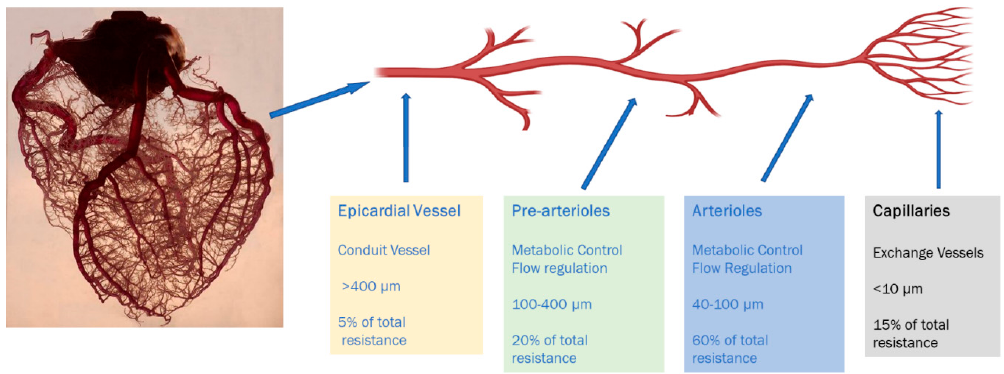
Figure 1. Anatomical and functional classification of the coronary macro and micro-arterial system.